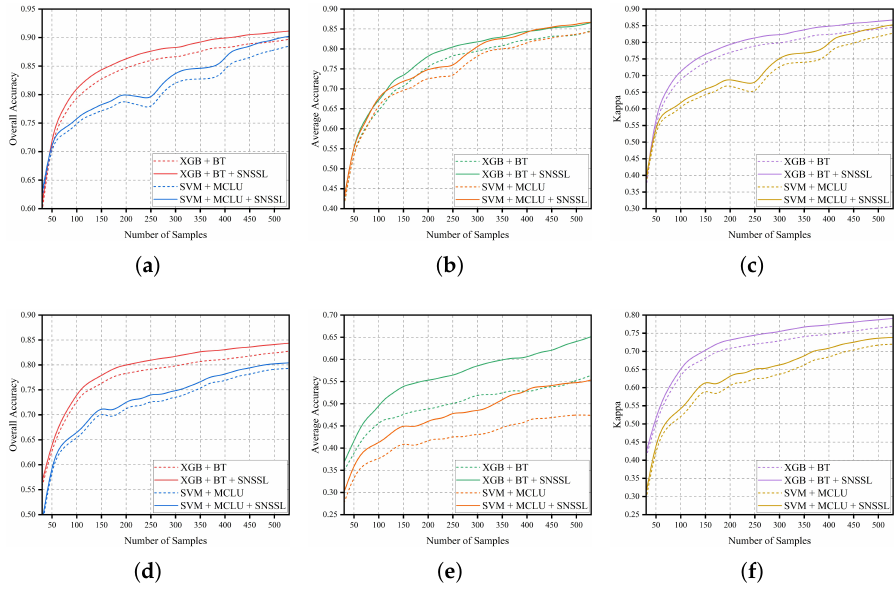
Figure 10. Training curves of FloodNet images: ( a ) OA of 6651; ( b ) AA of 6651; ( c ) Kappa of 6651;